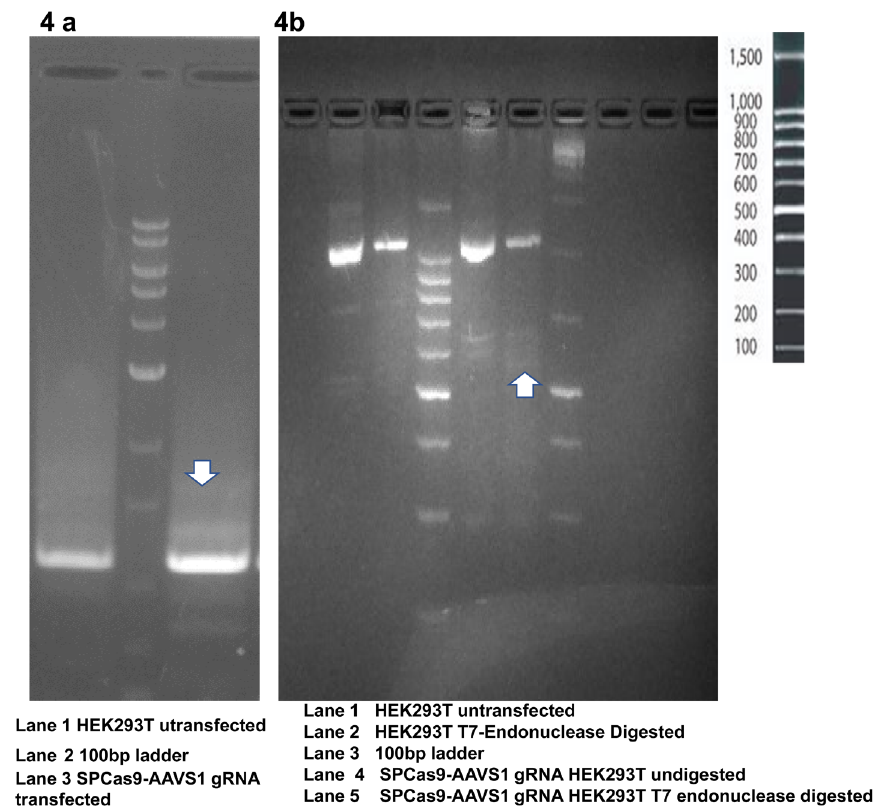
Figure 4. Agarose gel electrophoresis of PCR amplified products. 4a The PCR product (even without T7 digestion) shows a distinct band pattern resulting from the formation of heteroduplex. 4b . PCR amplified product after digestion with T7 endonuclease shows faint bands resulting from the digestion of